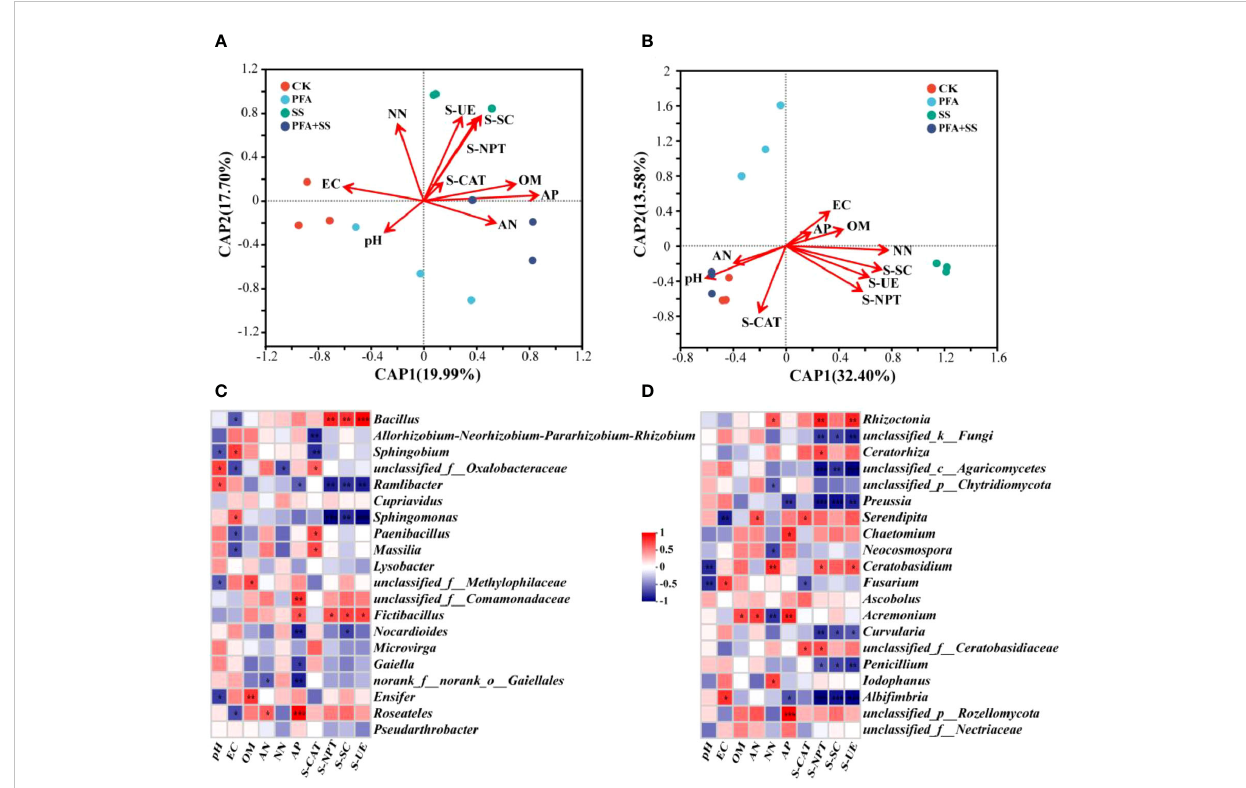
FIGURE 6 The db-RDA of bacterial (A) , fungal (B) communities and properties, enzyme activities in the rhizosphere soil of the seedlings, and correlation heat maps of properties, enzyme activities and the relative abundances of top 20 dominant genera of bacteria (C) , fungi (D) in the rhizosphere soil samples. CK, the seedlings without PFA and salt stress; PFA, the seedlings amended with PFA and without salt stress; SS, the seedlings with salt stress; PFA+SS, the seedlings amended with both PFA and salt stress. EC, Electrical conductivity; OM, Organic matter; AN, Ammonium nitrogen; NN, Nitrate nitrogen and AP, Available phosphorus. S-CAT, soil catalase; S-NPT, soil neutral protease; S-SC, soil sucrase; S-UE, soil urease. * p <0.05, ** p <0.01, and *** p